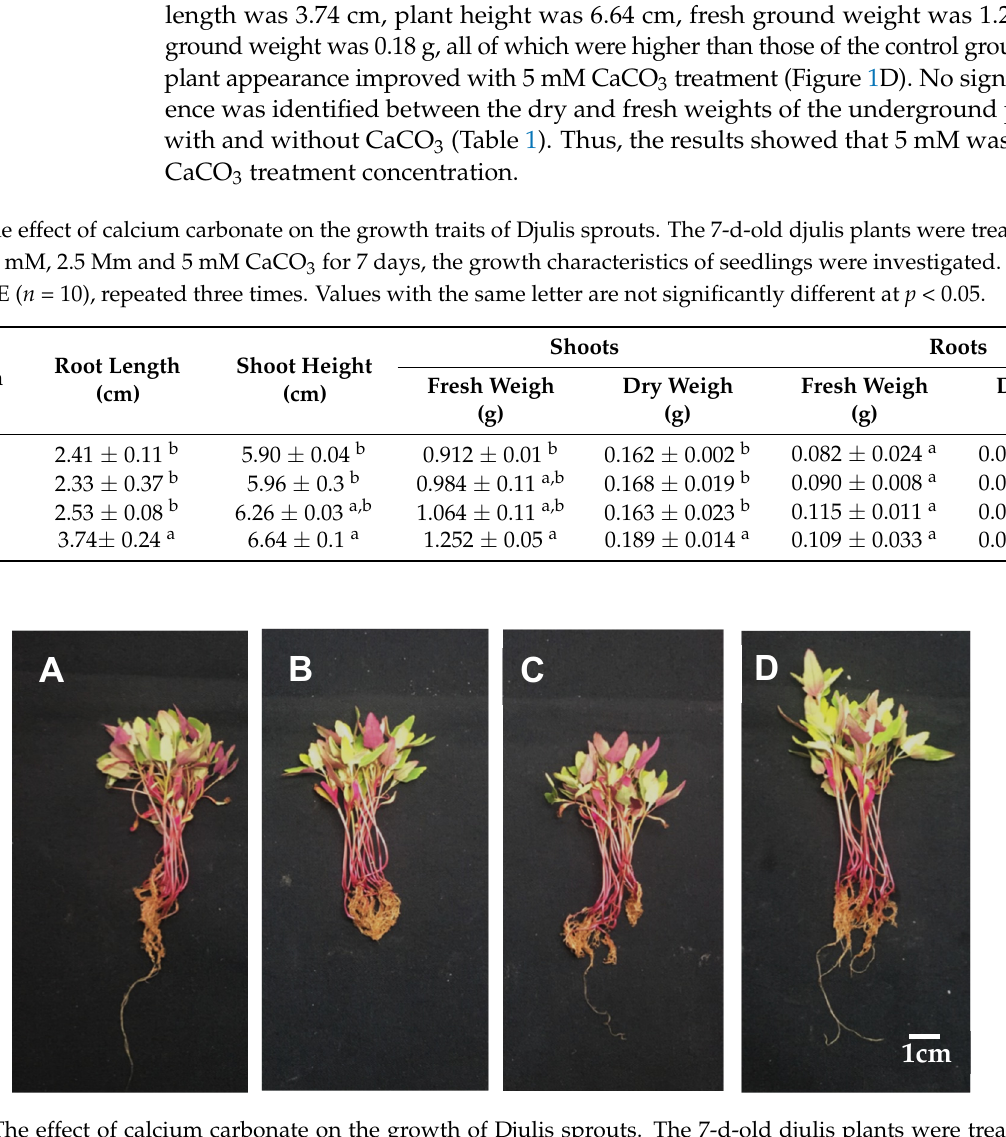
Figure 1. The effect of calcium carbonate on the growth of Djulis sprouts. The 7-d-old djulis plants were treated with 0 mM ( A ), 1.25 mM ( B ), 2.5 mM ( C ) and 5 mM ( D ) CaCO 3 for 7 days, the growth characteristics of seedlings were recorded. (Scale bar = 1.0 cm). Table 1 . The effect of calcium carbonate on the growth traits of Djulis sprouts. The 7-d-old djulis plants were treated with 0 mM, 1.25 mM, 2.5 Mm and 5 mM CaCO 3 for 7 days, the growth characteristics of seedlings were investigated. Data are means ± SE ( n = 10), repeated three times. Values with the same letter are not significantly different at p < 0.05. CaCO 3